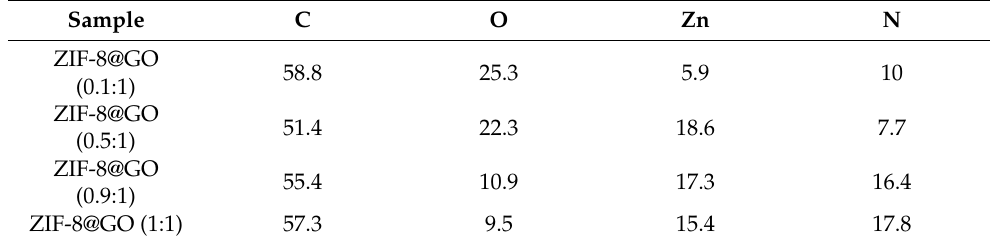
Table 3. Elemental composition obtained from SEM-EDS element analysis of synthesized composites.